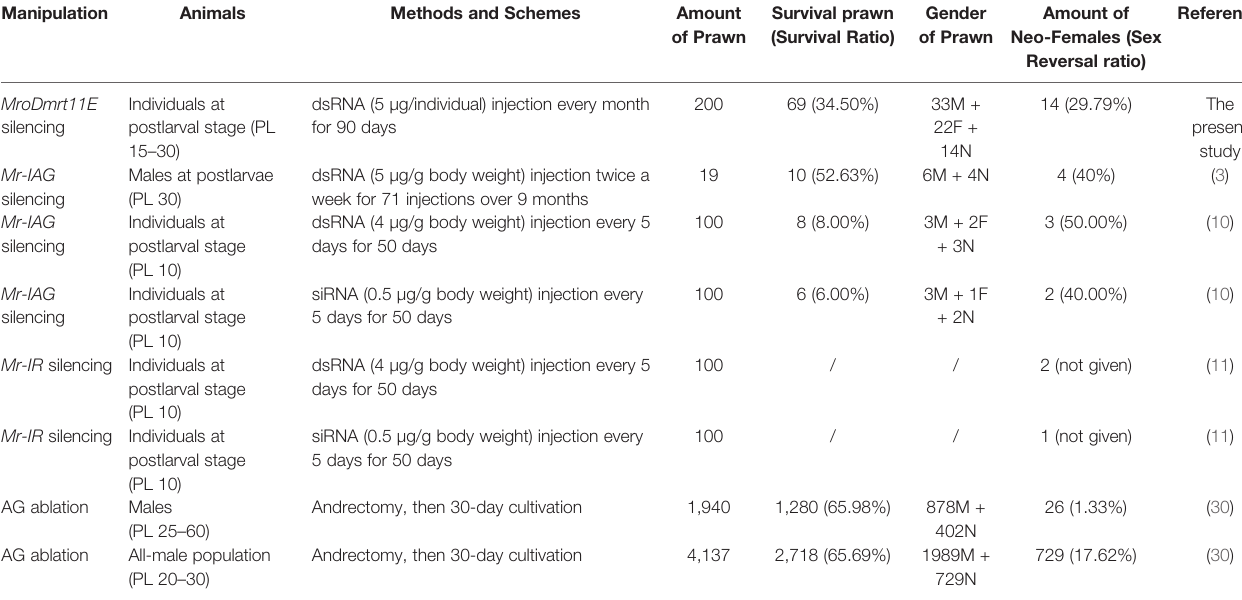
TABLE 1 | The summary of sex reversal induction and neo-female production in Macrobrachium rosenbergii . Manipulation Animals Methods and Schemes Amount